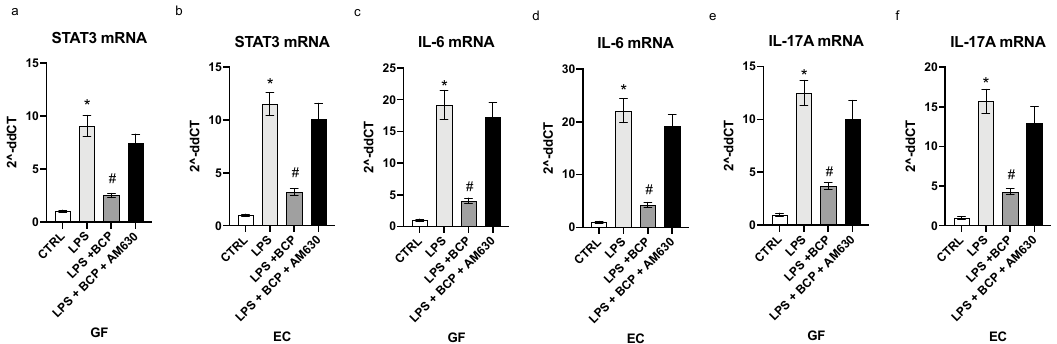
Figure 4. The graphs represent qPCR results of STAT3 ( a ), IL-6 ( c ), IL-17A ( e ) mRNA expression from GF cells and STAT3 ( b ), IL-6 ( d ), IL-17A ( f ) mRNA expression from EC cells. Values are expressed as the means and SD. * p < 0.0001 vs. CTRL; # p < 0.0001 vs LPS.